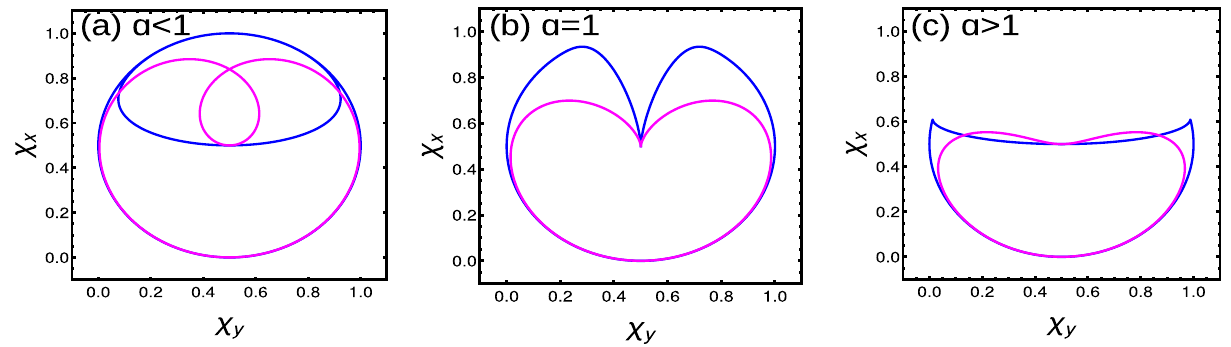
Figure 11. (Color online) Behavior of winding vectors of Hermitian SSH chain witnessing the topological transition along the critical line t and magenta represents T